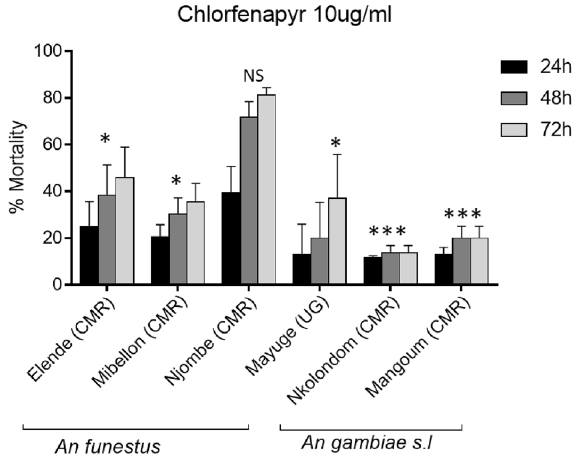
Figure 2. Comparative susceptibility pattern of field An. gambiae and An. funestus using the LC 50 obtained with kisumu. Percentage mortality (24 h, 48 h and 72 h) after exposure to chlorfenapyr 10 µg/ml (with acetone as solvent); * indicate significant difference compared to Kisumu.